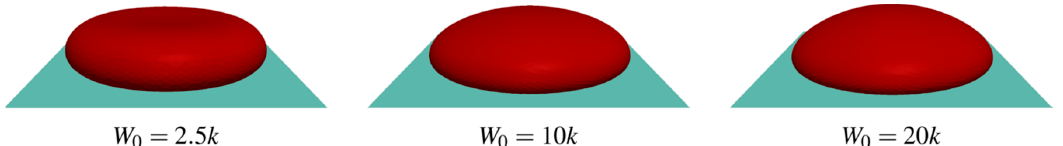
Figure 12. Computed shapes of a RBC in contact with cylinders for different adhesion (adapted from [191] with permission).